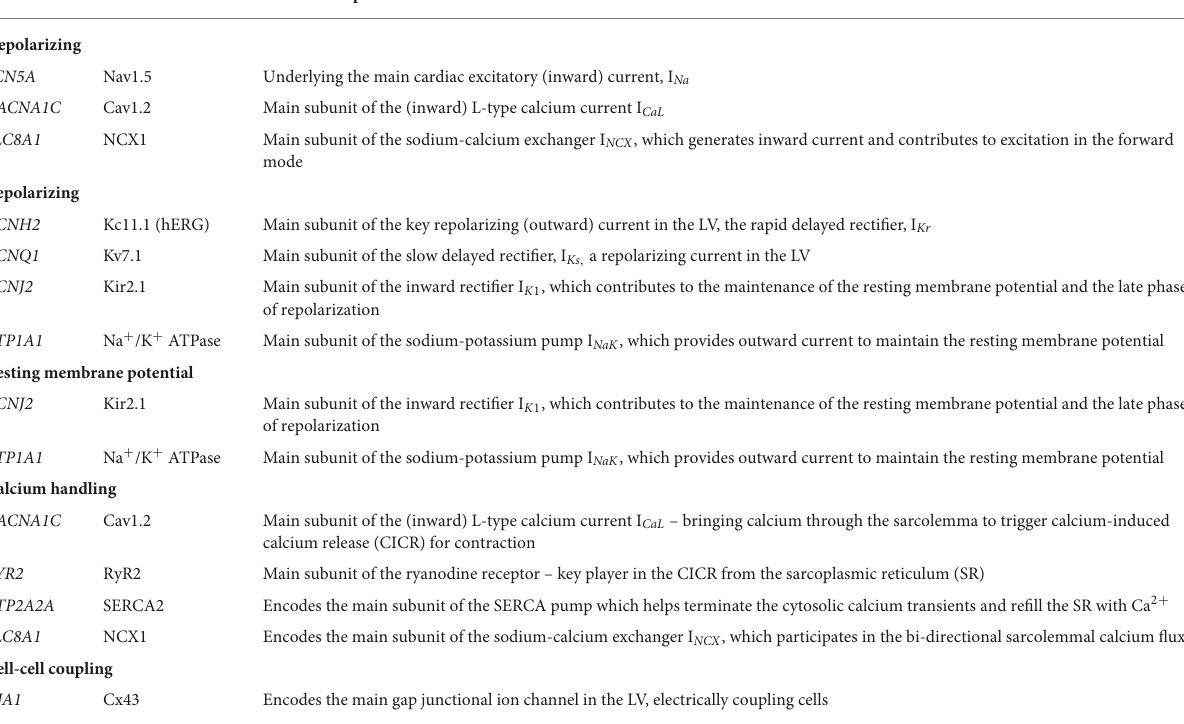
TABLE 2 Genes, proteins and ion channels in the